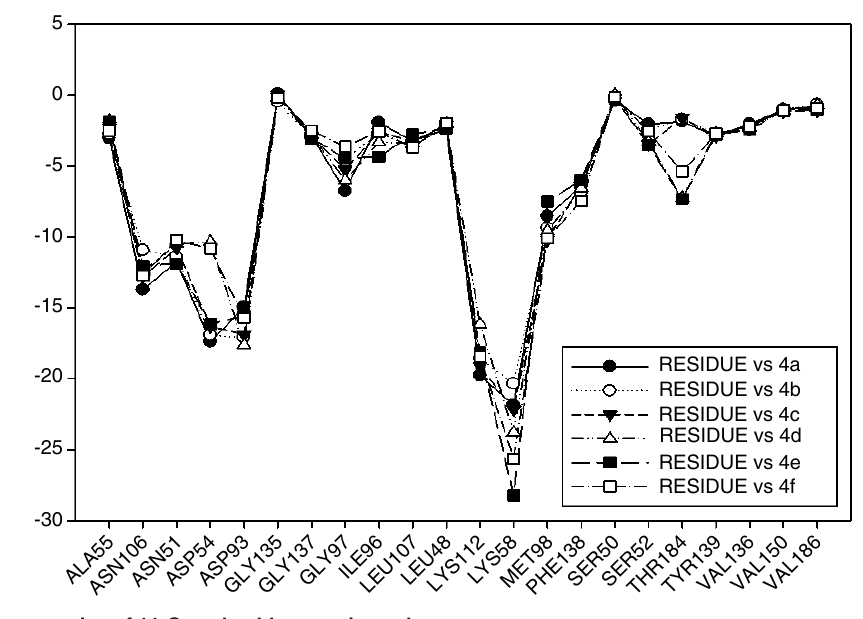
Figure 12. Interaction energies of 11-O-acyl geldanamycin analogues.